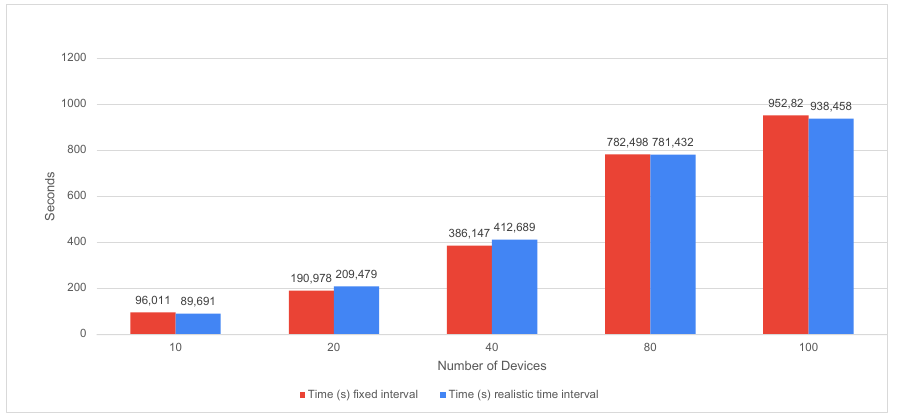
Figure 11. Elapsed time loading data for every 15 min for 1 year using equally spaced vs realistic spaced timestamps.